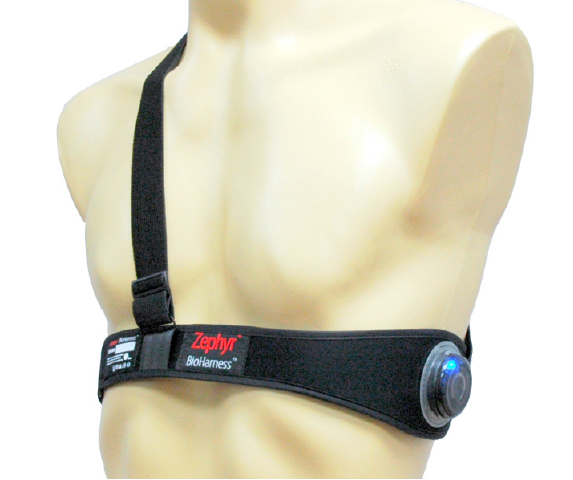
Figure 5. Zephyr TM Bioharness reference K113045.